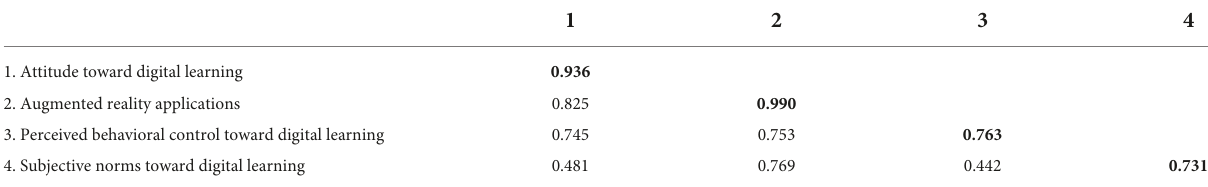
TABLE 3 Discriminant